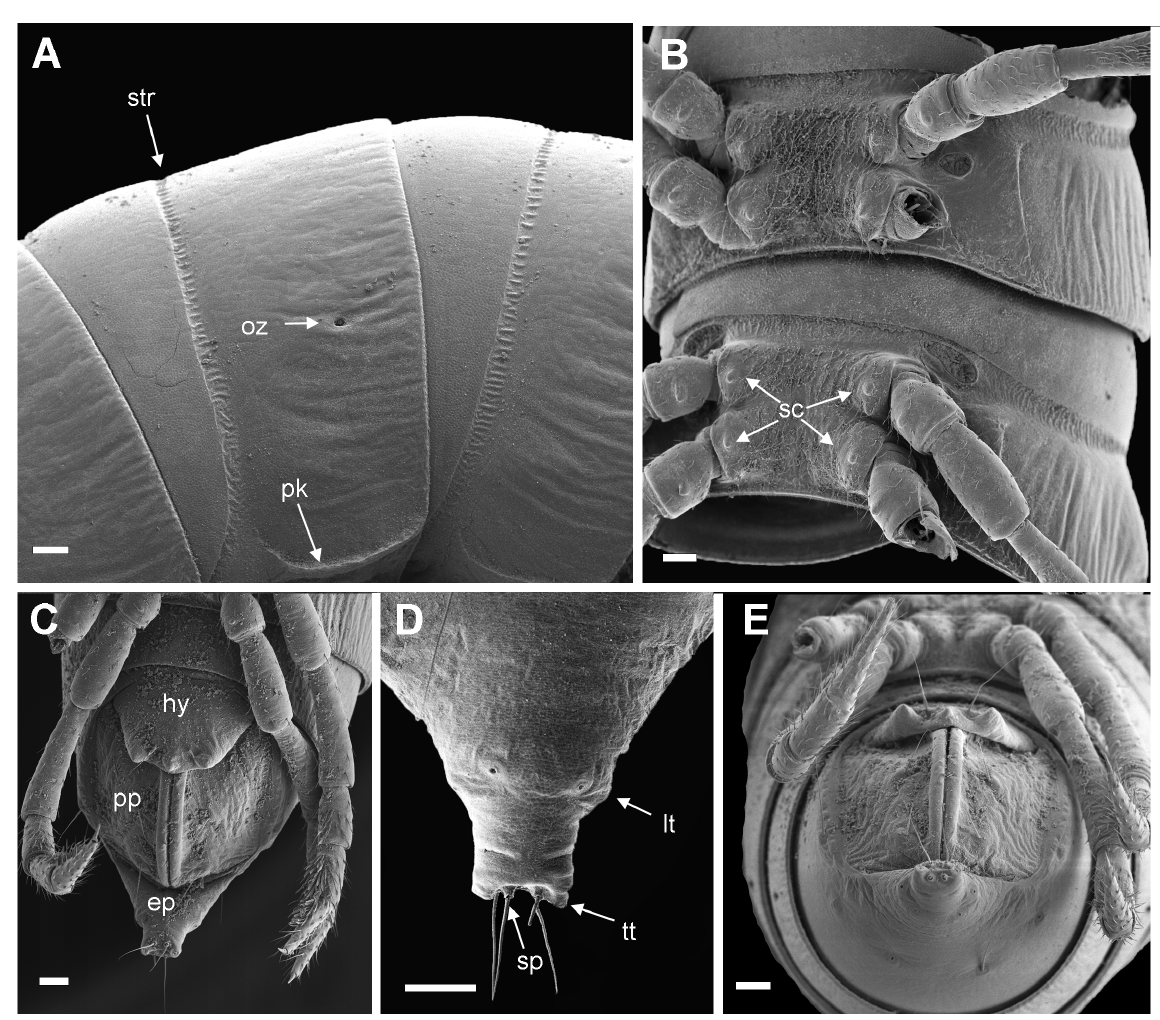
Fig. 5. Eviulisoma paradisiacum sp. nov., ♂. A . Two midbody rings, lateral view, showing pleurosternal keel and striolate stricture. B . Two midbody rings, ventral view, showing sternal cones. C–E . Telson. C. Ventral view. D. Dorsal view. E. Posterior view. Abbreviations: ep = epiproct; hy = hypoproct; lt = lateral tubercle; oz = ozopore; pk = pleural keel; pp = paraproct; sc = sternal cone; sp = spinneret; str = stricture; tt = terminal tubercle. Scale bars: 0.1